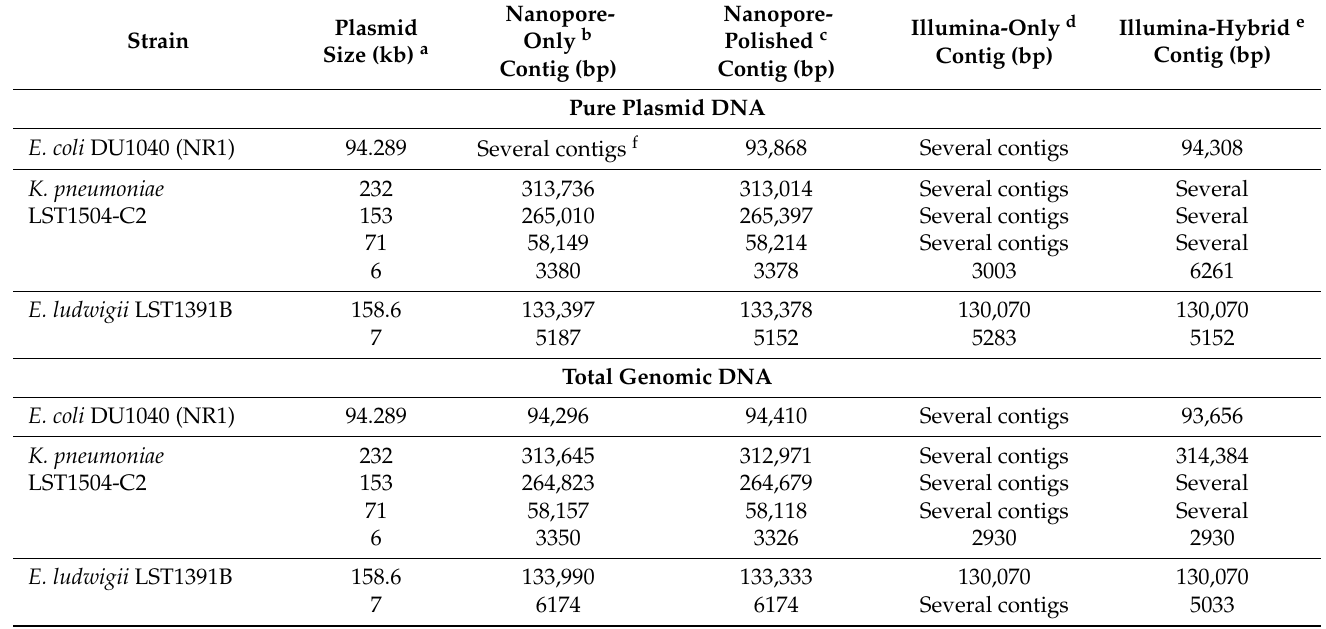
Table 1. Plasmid sequences inferred from the Nanopore and/or Illumina sequencing assemblies of pure plasmid DNA or of total genomic